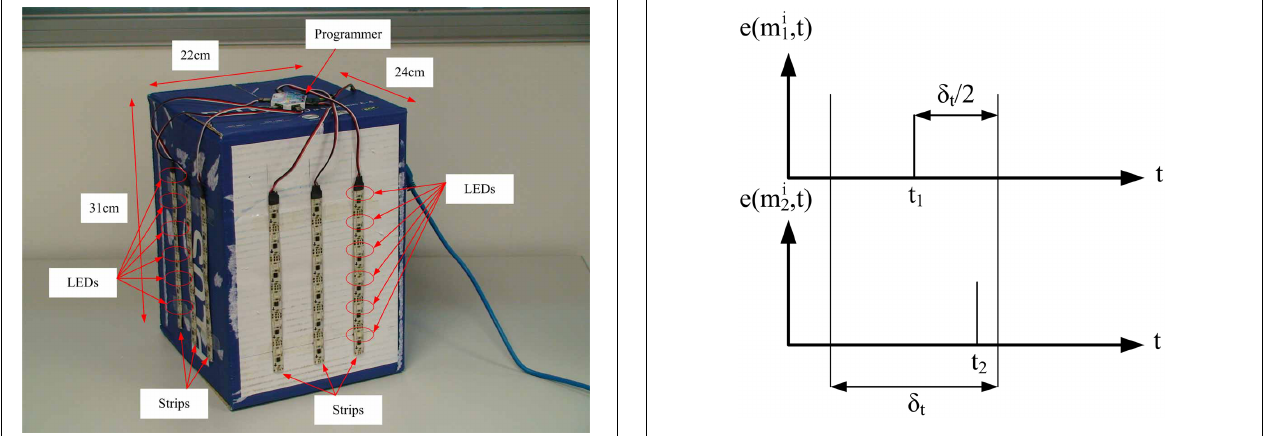
FIGURE 2 | Photograph of the calibration structure, with 36 LEDs distributed in two orthogonal planes. The size of the object is shown in the figure.